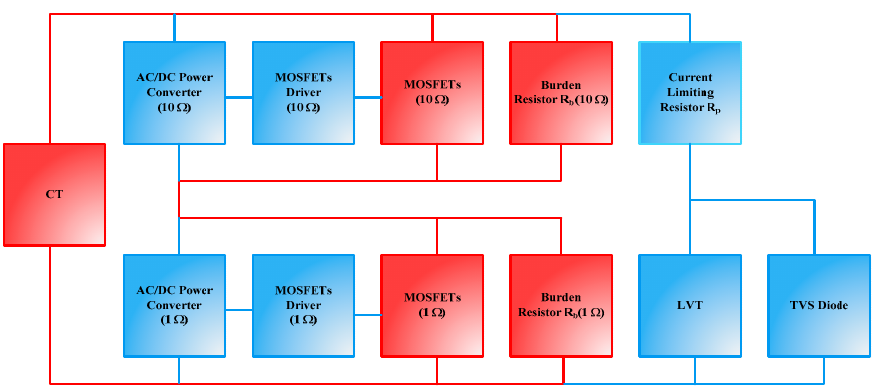
Figure 5. Block diagram of autoranging circuit for